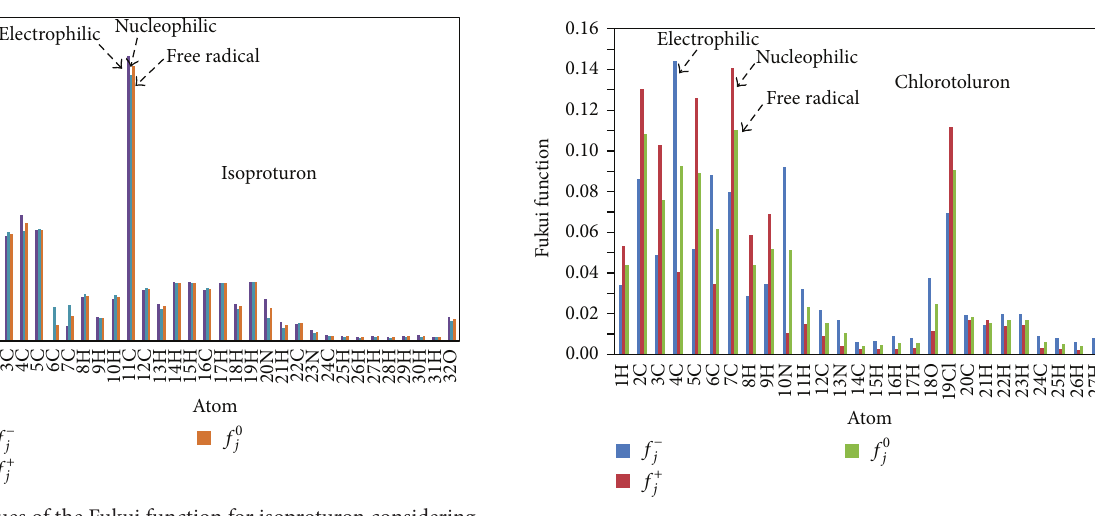
Figure 6: Values of the Fukui function for chlorotoluron consider- ing Hirshfeld charges according to